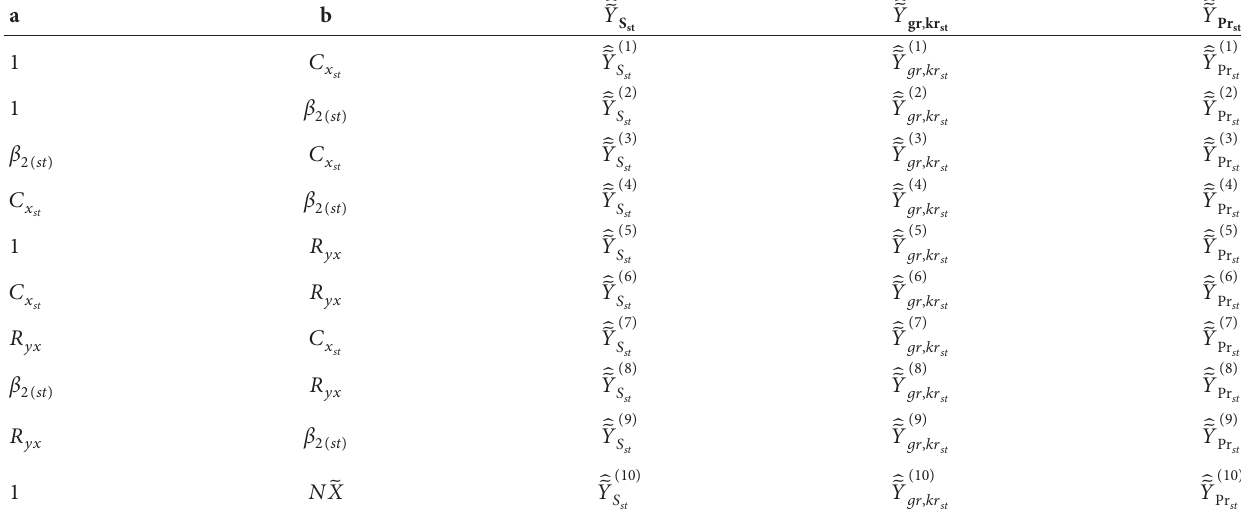
Table 1: Members of our proposed and existing